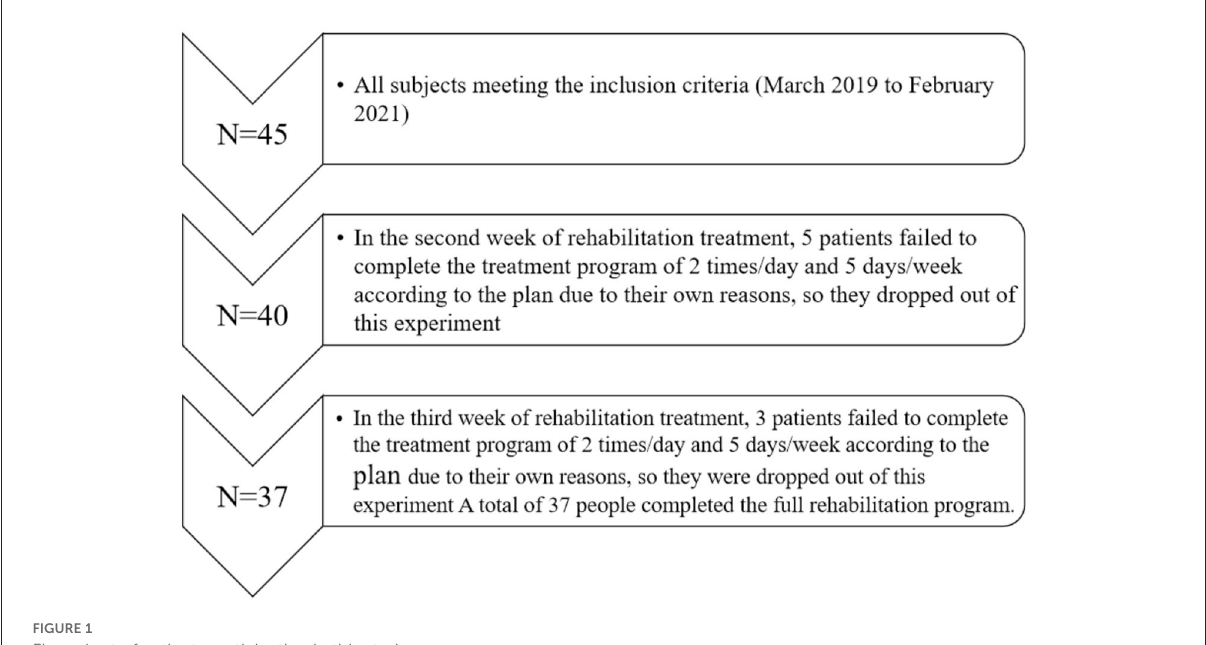
FIGURE1 Flow chart of patients participating in this study.